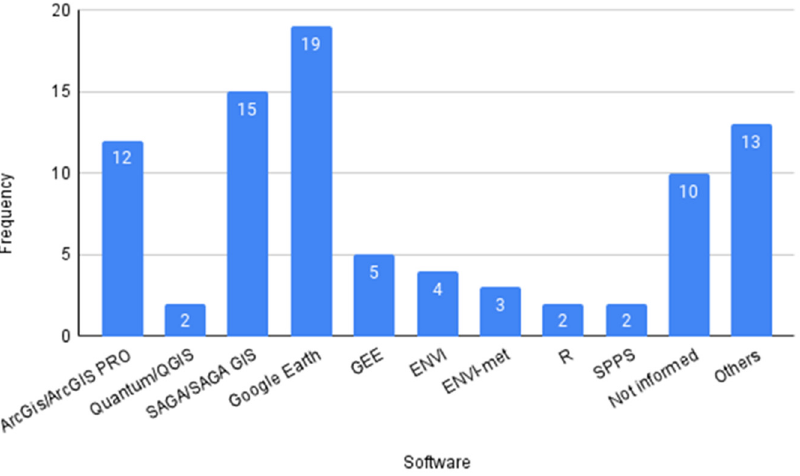
Figure 13. Software most used in the reviewed articles. GEE: Google Earth Engine; ENVI: Environ- ment for Visualizing Images; R: R language; SPPS: Statistics Package for the Social Science.